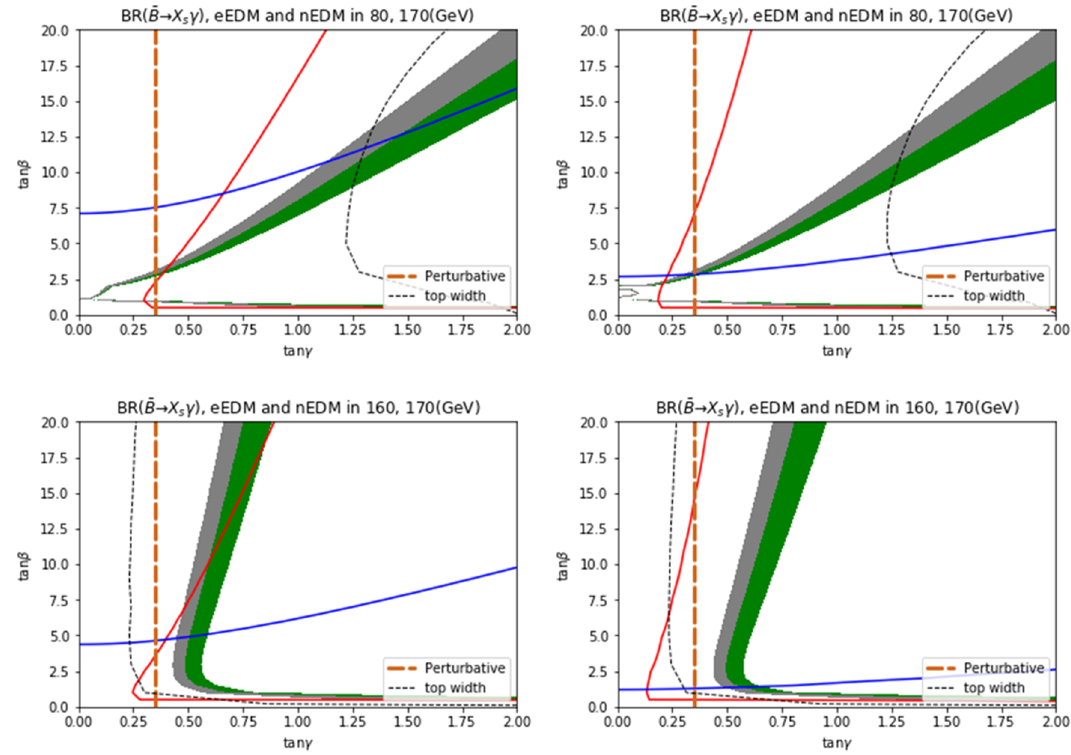
Figure 16 . The allowed regions from ¯ B → X s γ (within the green and grey shaded areas), eEDM (above the blue line), and nEDM (to the right of the red line) in the [ tan γ, tan β ] plane, with M = 170 GeV. In the upper panels M = 80 GeV, θ = − 0 . 3 , and δ = 0 . 96 π (left) or 0 . 985 π H + 3 H + 2 (right). In the lower panels M = 160 GeV, θ = − 0 . 5 , and δ = 0 . 8 π (left) or 0 . 95 π (right). We also H + 2 show constraints from the top-quark width (black dotted line) and perturbativity (orange dashed line), wherein the region to the right of the respective curves is